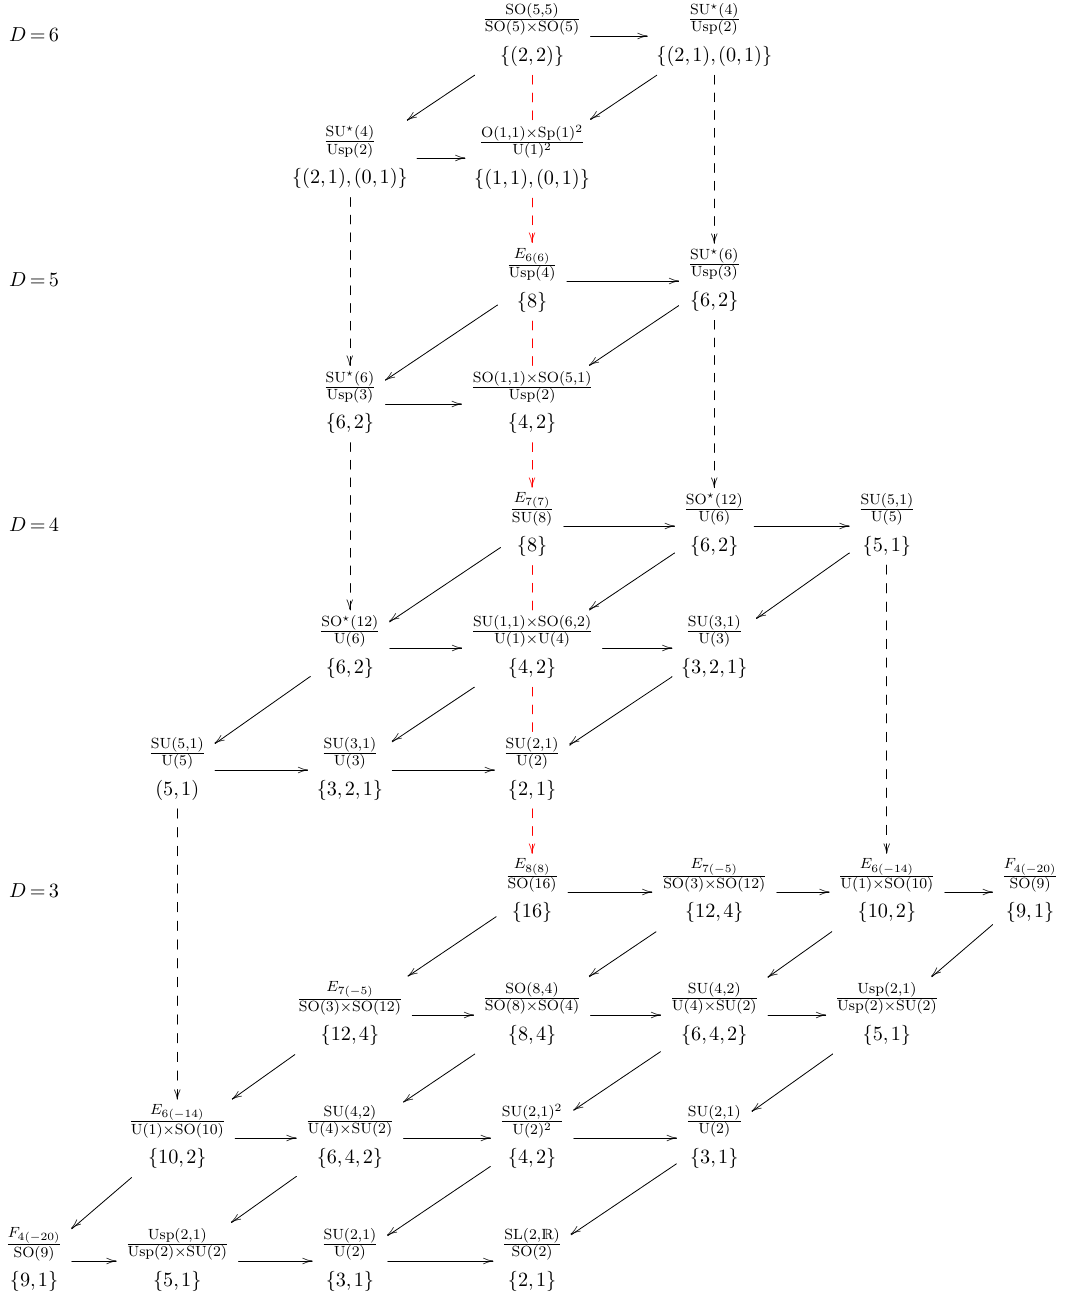
Table 1 . Pyramid of twin supergravities generated by the product of left and right super Yang- Mills theories in D = 3 ; 4 ; 5 ; 6. Each level is related by dimensional reduction as indicated by the vertical arrows. The horizontal arrows indicate consistent truncations e(cid:11)ected by truncating the left or right Yang-Mills multiplets. All such supergravity theories have a twin except for the maximal cases along the \exceptional spine" highlighted in red. Note, D = 3 is the exception to the exceptions in that maximal N = 16 supergravity does have a ‘trivial’ N = 1 twin, but it is not obtained from the double-copy procedure